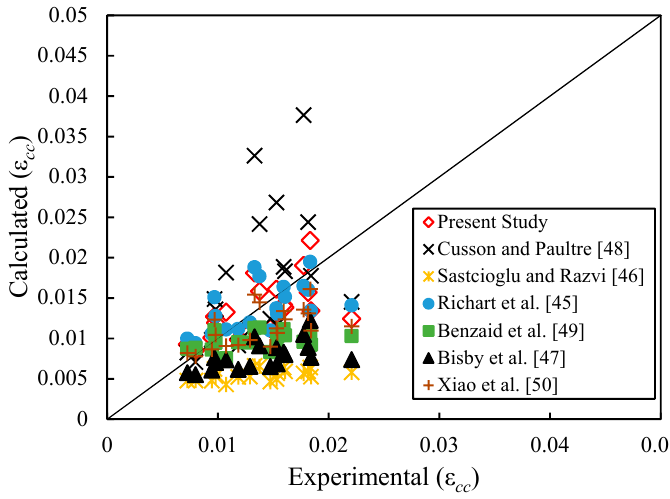
Figure 23. Performance of various confinement models in predicting strain at peak strength.